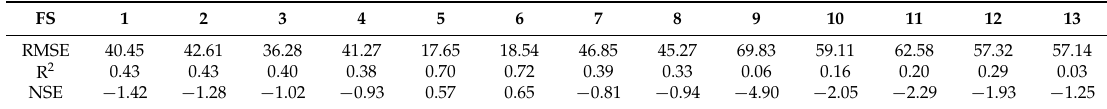
Table 3. Validation of the FD kelp detection results with dive transect mappings per flight stripe